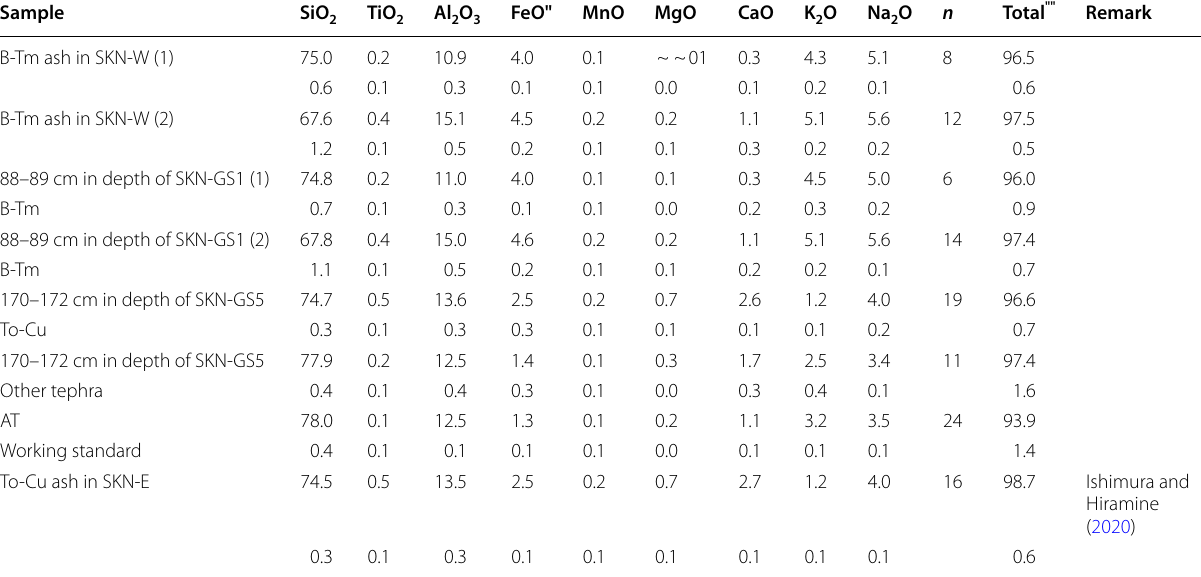
The number on the upper line is the mean value and that on the lower line is the standard deviation. Measured values were recalculated to 100% on a water-free basis. FeO*, total iron oxide as FeO. Total**, raw data before